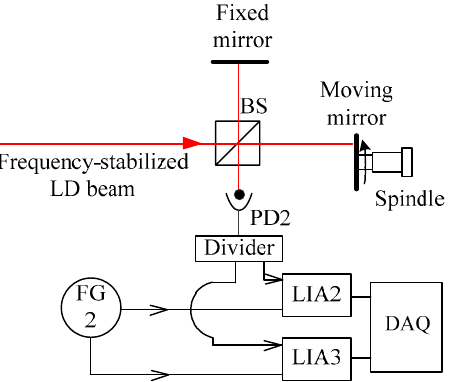
Figure 2. Axial error of a high-speed spindle measuring system. PD: photodetector; LIA: lock-in amplifier; FG: function generator; DAQ: data acquisition.